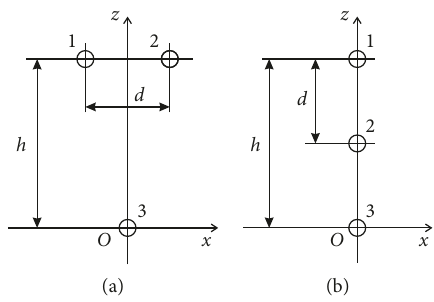
Figure 4: Dipole arrays in free space: (a) H-array; (b)